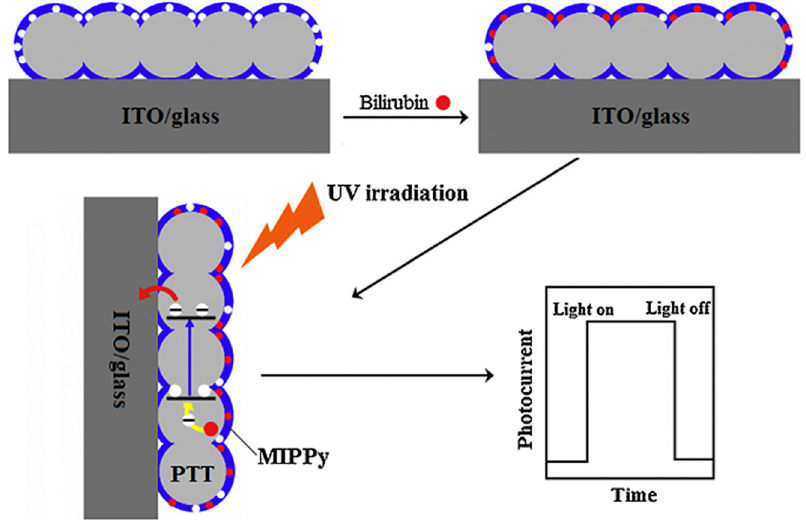
Figure 4. Schematic illustration for the detection mechanism of the bilirubin photoelectrochemical sensor. Reprinted with permission from [45]. ©2015 Elsevier.